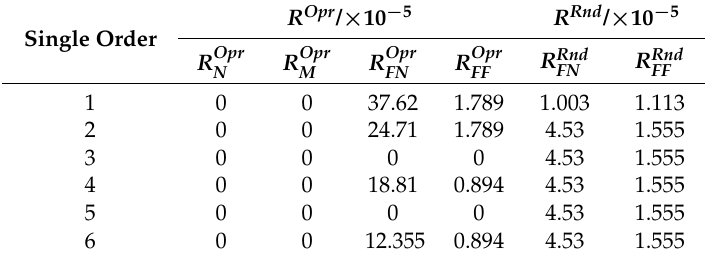
Figure 8. Risk assessment results. Table 3. Risk of dispatching order.